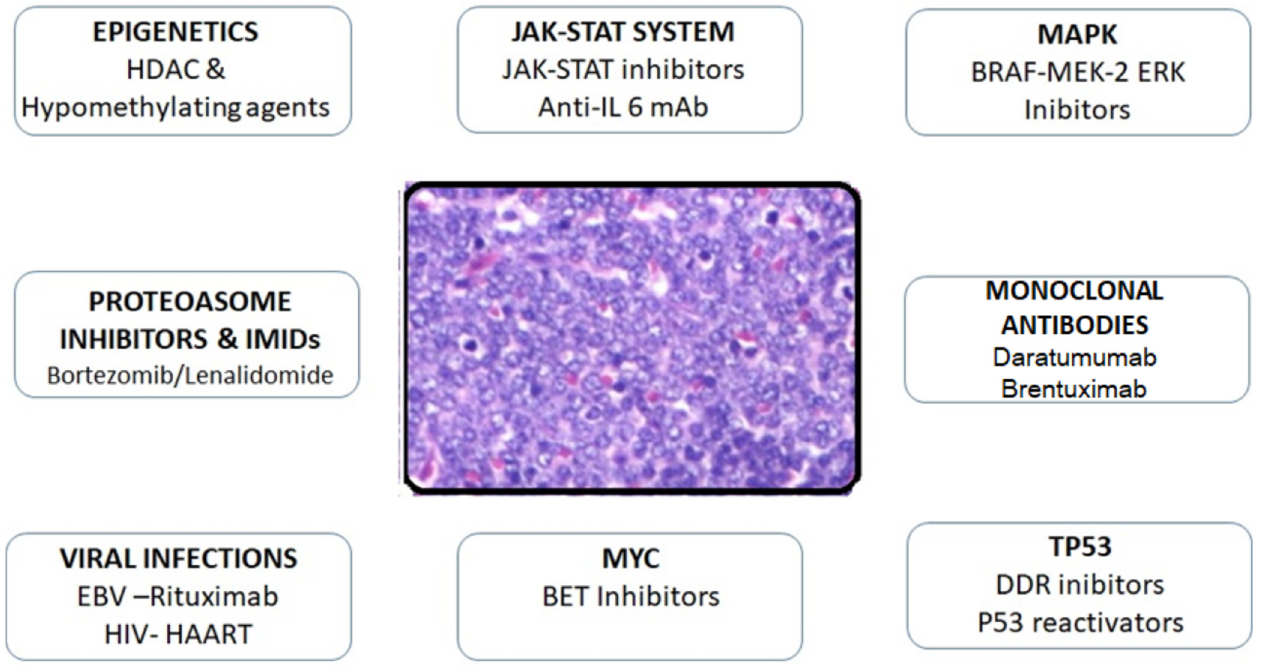
Figure 6. Different therapeutic options and targets in PBL, Modified from Pileri SA, Mazzara S, and Derenzini E [58]. Abbreviations: (HDAC: histone deacetylase, BRAF: B-Raf proto-oncogene, MEK: mitogen-activated protein kinase, ERK: mitogen-activated protein kinase, DDR: DNA damage response pathway, BET: bromodomain and extra terminal protein, HAART: highly active anti-retroviral therapy).